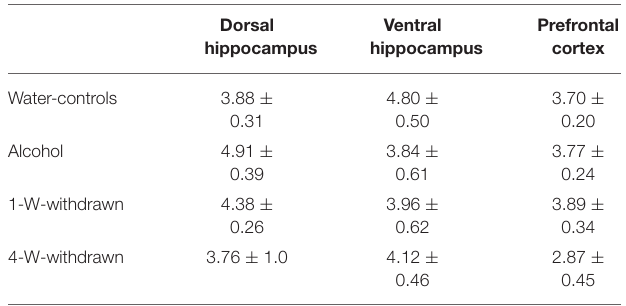
TABLE 1 | Basal corticosterone concentrations (ng/mL) in naïve condition in the dorsal hippocampus, the ventral hippocampus and the prefrontal cortex. Dorsal Ventral hippocampus